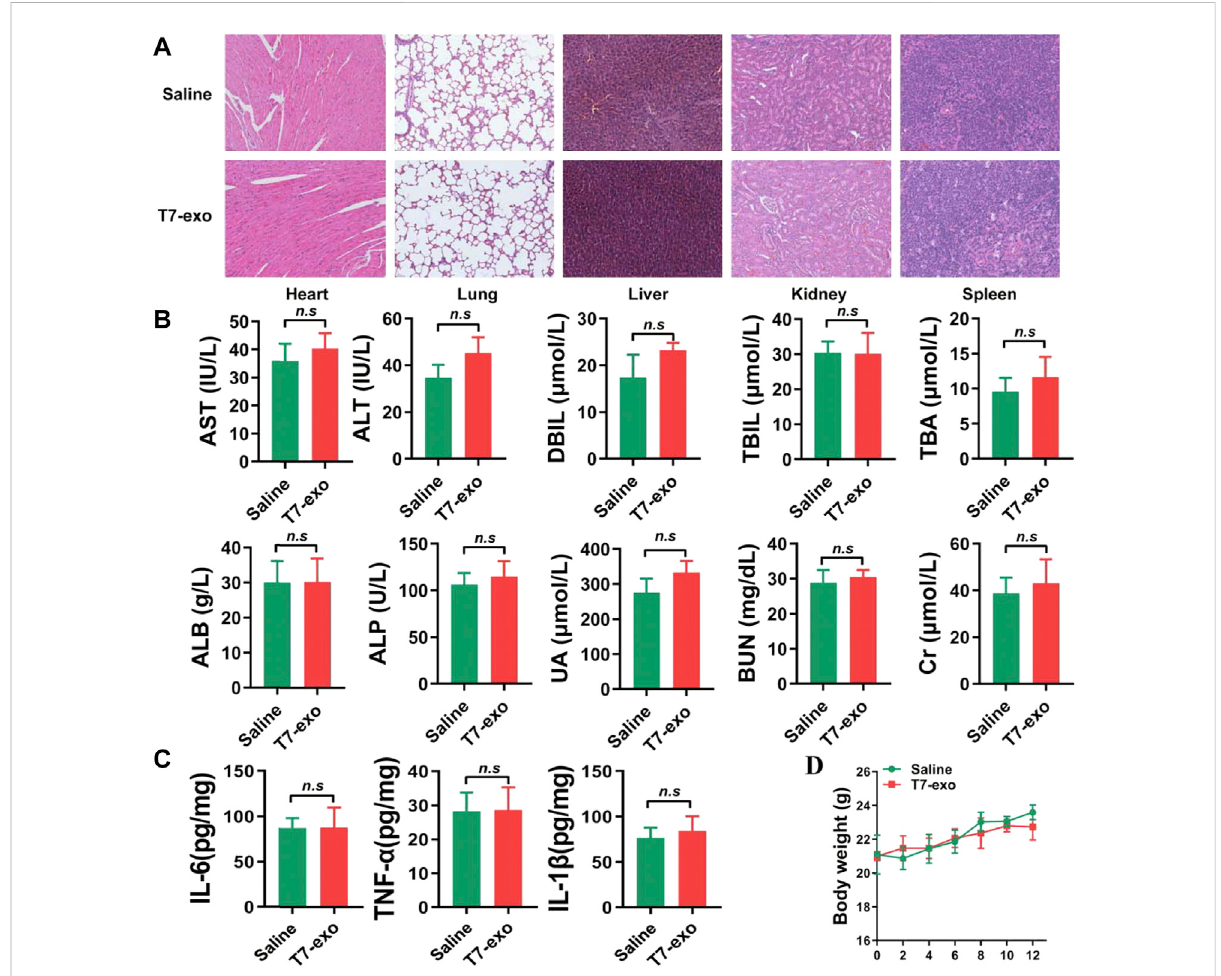
FIGURE 7 ThesystematictoxicityassessmentofT7-siYY1-exo. (A) Histologicalanalysesofliver,heart,kidney,lungandspleensectionsstainedwithH&Eof BALB/c mice post-intravenous injection of T7-siYY1-exo (200 μ g) or Saline for 12 days (one dose every other day). (B) Clinical chemistry and hematology parameters for T7-siYY1-exo treated mice. p values are displayed as not signi fi cant (ns) for p > 0.05. (C) The expression level of serum in fl ammatory cytokines TNF- α , IL-1 β and IL-6. (D) Body weight changes in T7-siYY1-exo treated